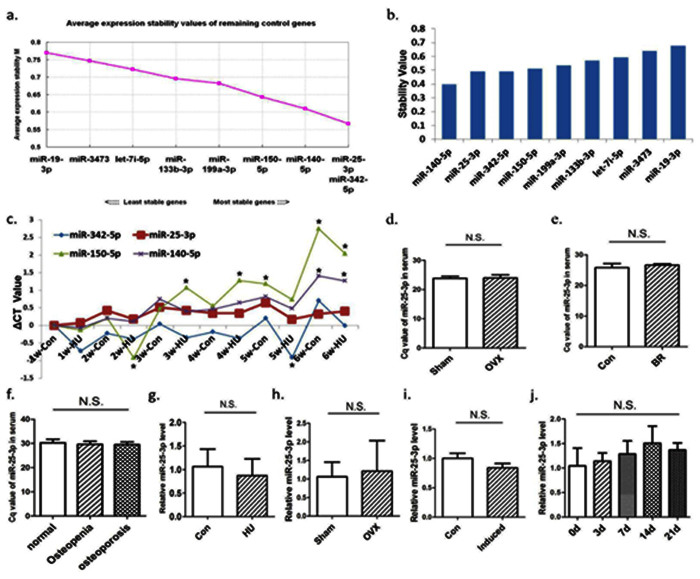
Identified miR-25-3p as the suitable reference gene for osteoporosis.(a) Ranking of candidate reference genes by geNorm, the most stable pair was recommended as miR-25-3p and miR-342-5p. (b) Ranking of candidate reference genes by NormFinder. (c) The expression pattern of candidate gene during hindlimb-unloading (HU) within 6 weeks, miR-25-3p showed as the most stable gene. *p < 0.05, HU. VS. CN, n = 6, N = 72. (d) miR-25-3p was detected in the serum of Sham and OVX rats (n = 12). (e) Rhesus monkeys with (n = 6) or without bedrest (n = 9). (f) Postmenopausal women with normal BMD (n = 19) or with osteopenic (n = 7) or with osteoporosis (n = 10). (g) miR-25-3p in the femur of hindlimb-unloading for 4 W (n = 6). (h) miR-25-3p in the femur of OVX for 8 W (n = 6). (i) miR-25-3p in BMMs after osteoclastic induction for 4d (n = 3). (j) miR-25-3p in primary osteoblasts after osteogenic induction for 0d, 3d, 7d, 14d and 21d (n = 4). All these showed no significant differences (N.S.) (p > 0.05). BR: Bedrest group, Con: control group.